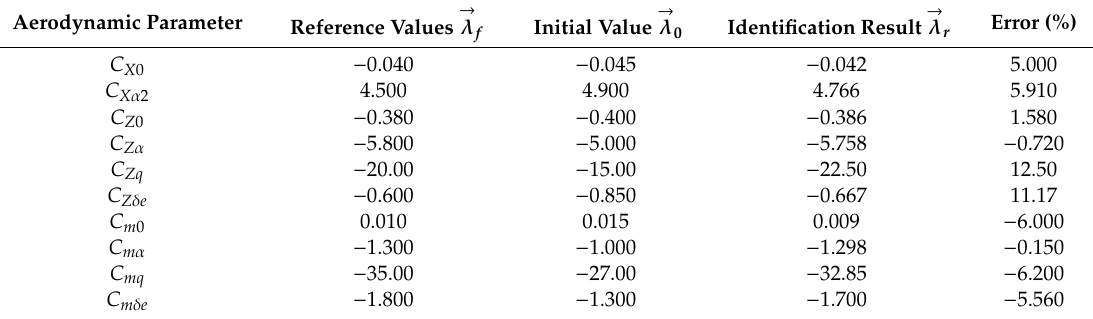
Table 2. Identification results for method